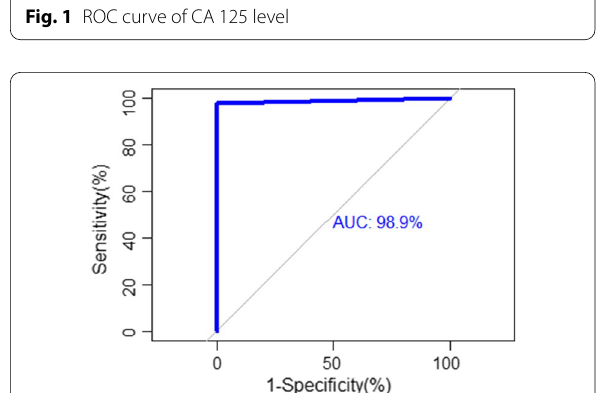
Fig. 2 ROC curve of PET/CT of local